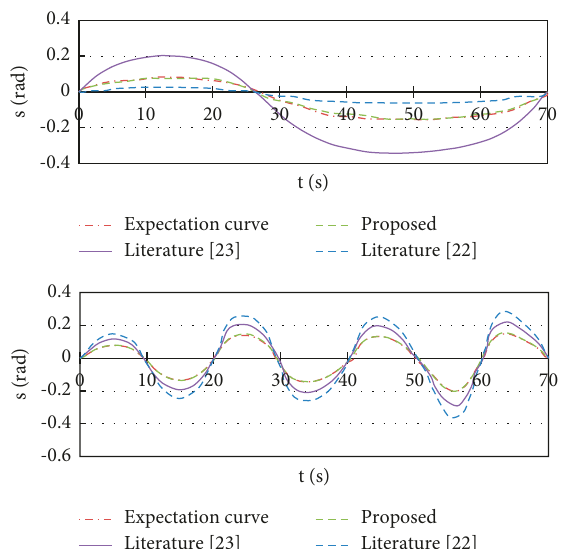
Figure 5: Joint 3 and joint 4 curves of manipulator.